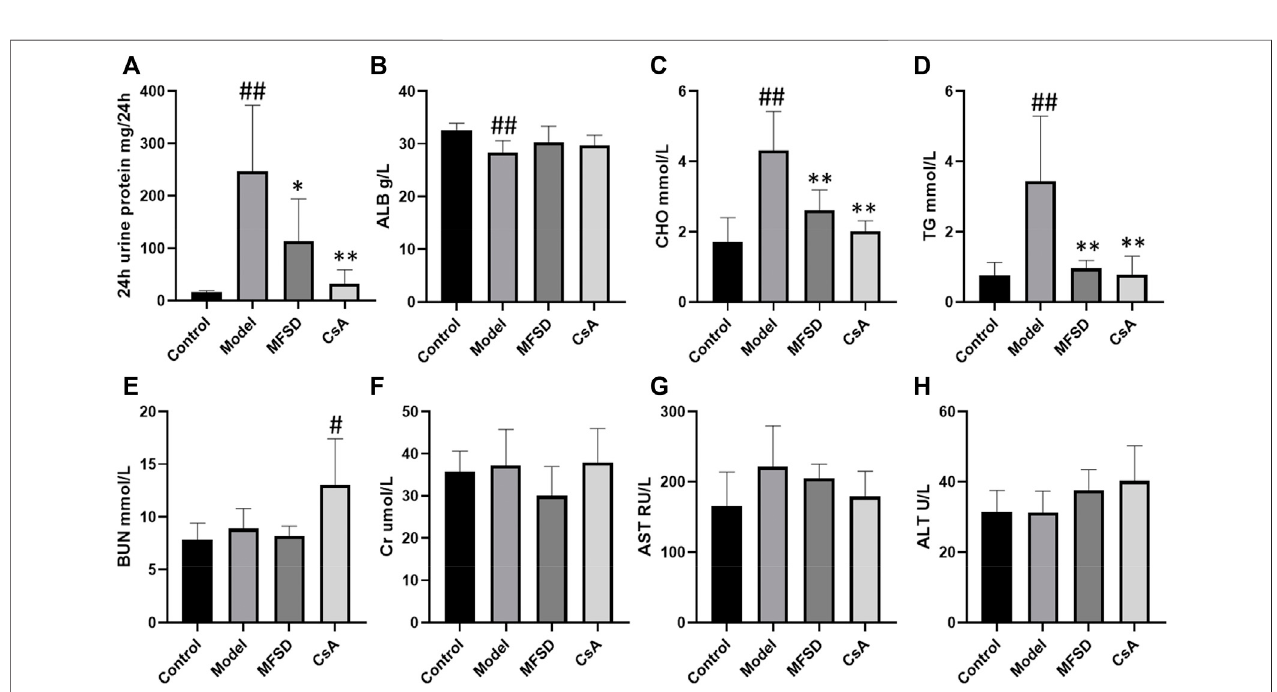
FIGURE1| TheeffectofMFSDonthe urine protein and serum biochemical indicators inPHN rats .(A) Thecontentsof24 hurine protein excretion inthe last week ( n =8) (B) ThelevelsofALBinserum( n =8) (C,D) ThelevelsofTCandTGinserum( n =8) (E,F) ThelevelsofBUNandCrinserum( n =8) (G,H) ThelevelsofALTandAST in serum ( n = 8). Data were expressed as mean ± SD. # p < 0.05 and ## p < 0.01 vs . control group, * p < 0.05 and ** p < 0.01 vs . model